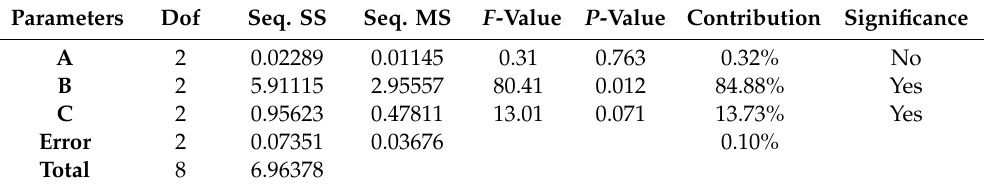
Table 2. Results of ANOVA tests for surface roughness.